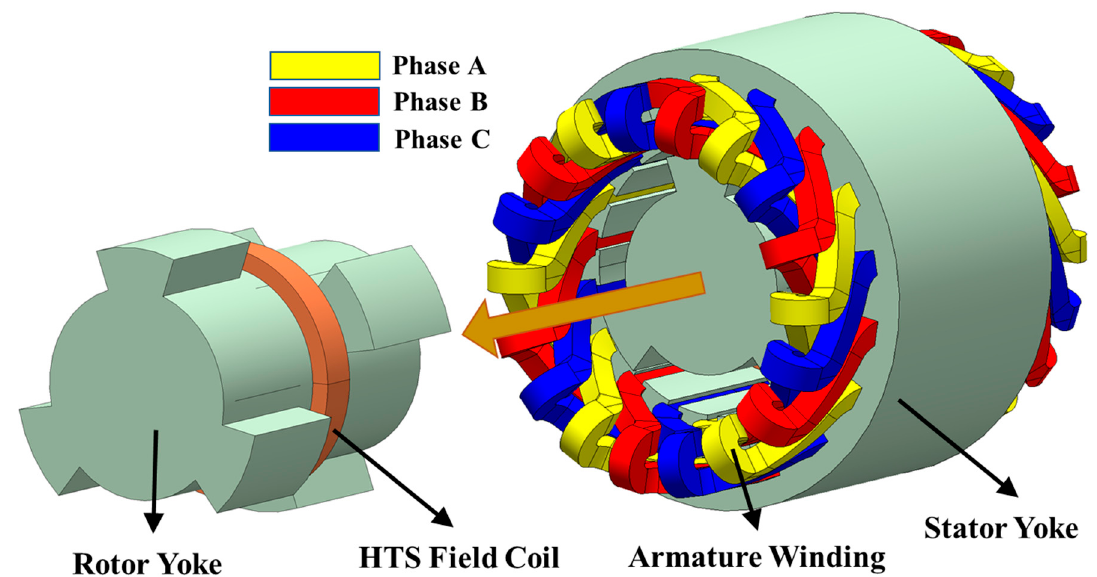
Figure 5. Fundamental structure of HTS homopolar synchronous machine.